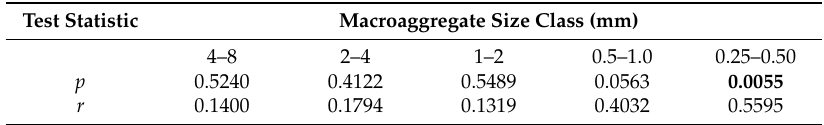
Table 3. Relationships between macroaggregate fractions (g g − 1 dry soil) and soil